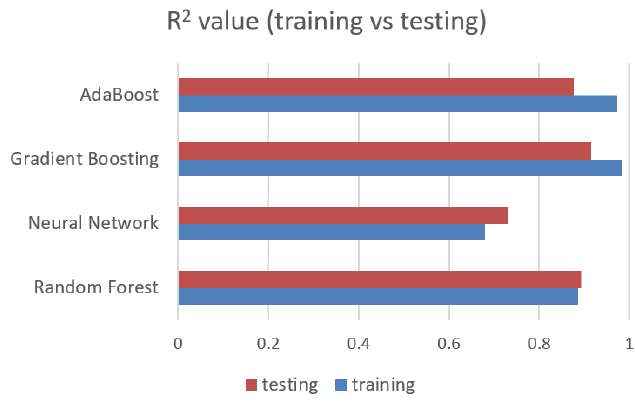
Figure 13. R 2 value (training vs. testing).